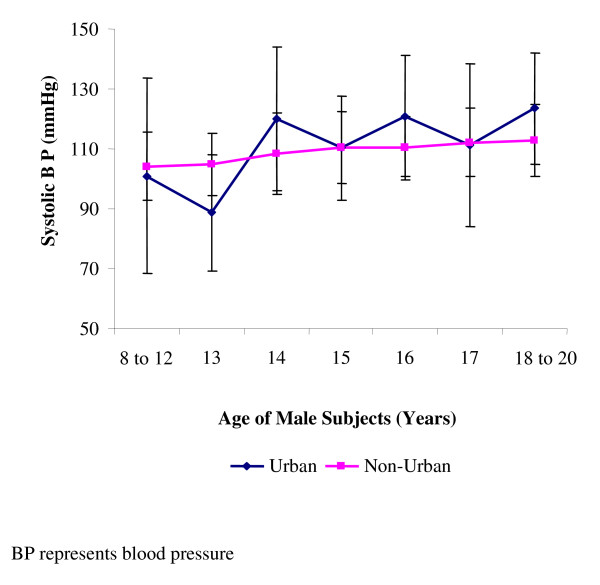
Mean systolic blood pressures of male subjects. Data (mean ± standard deviation) are for diastolic blood pressures of 615 males studied, and made up of 185 urban dwellers and 430 non-urban dwellers.